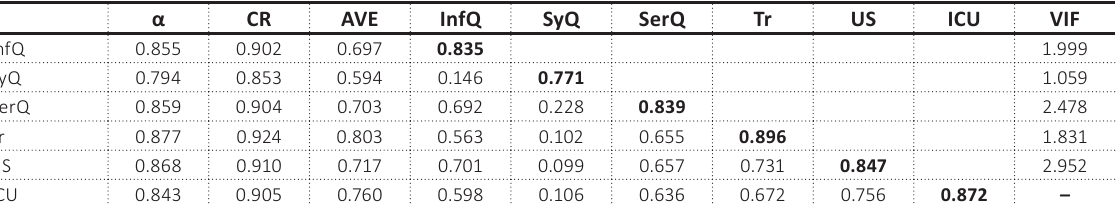
Table 3. Measurement model and multicollinearity